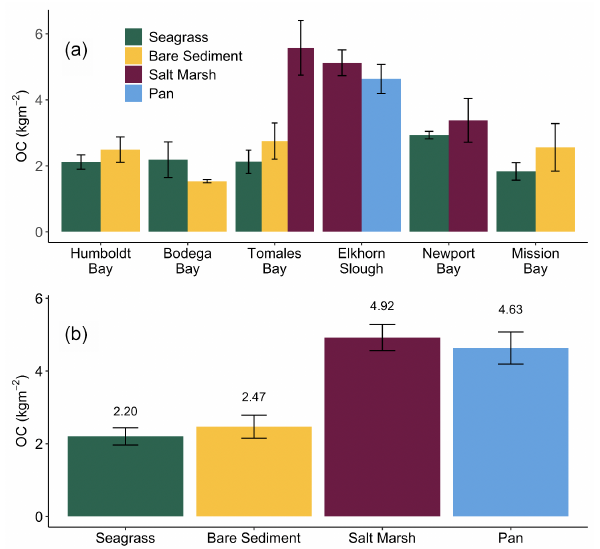
Figure 3. Average ( ± SE) total organic carbon (OC) stocks (kgm − 2 ) across all cores collected from each habitat type within each site in this study (a) . Average ( ± SE) total organic carbon stocks (kgm − 2 ) across all cores collected within each habitat type in this study (b) . Stocks are representative of the top 20cm of sedi- ment.